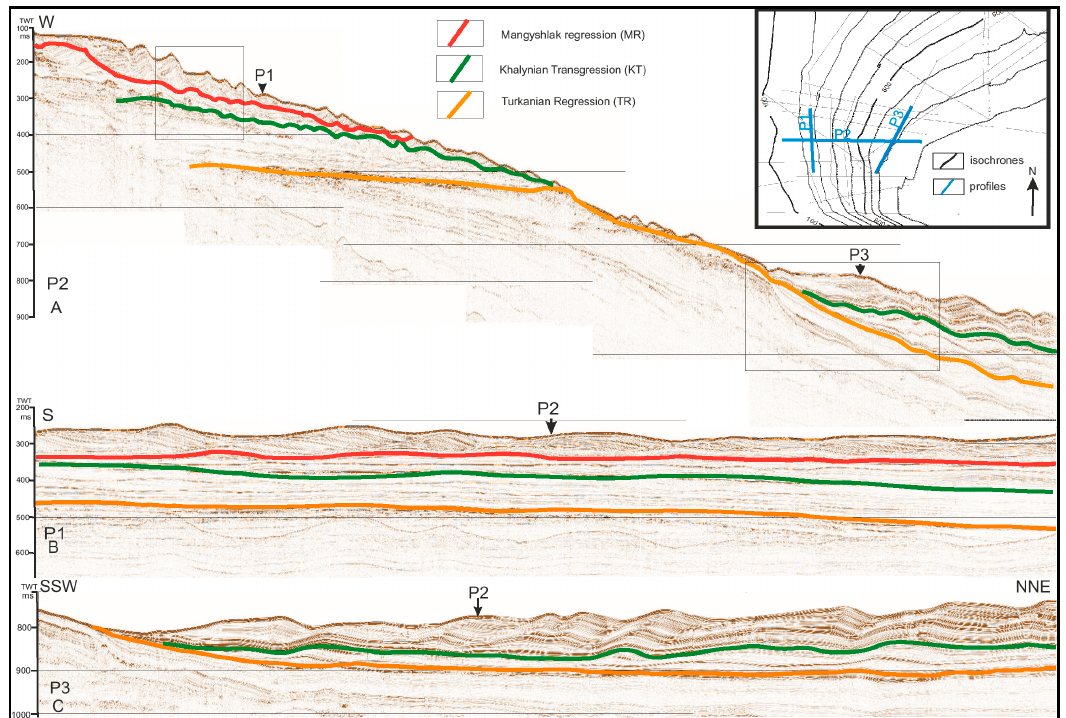
Figure 4. High resolution seismic profiles (sparker) on the western slope of the Derbent Basin off the Caucasus Mountains. ( A ) P2—Seismic profile P2, W-E across the slope; ( B ) P1—Seismic profile P1, S-N along the slope; ( C ) P3—Seismic profile P3, SW-NE along foot of the slope. Location in inset.